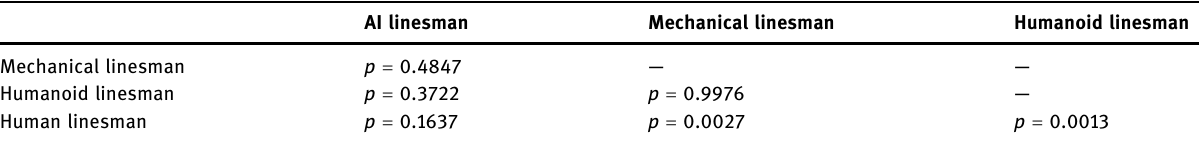
Table 2: Pairwise comparisons using Nemenyi multiple comparison test for linesmen preference AI linesman